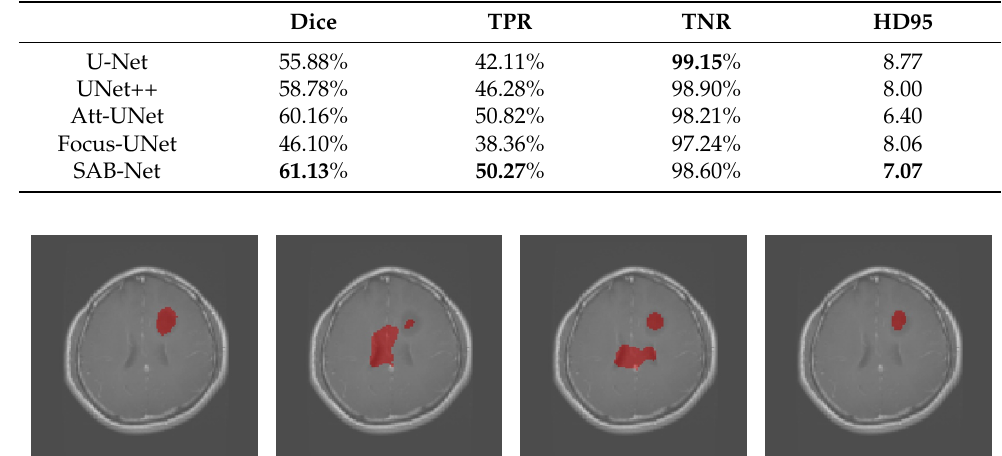
Figure 2. Qualitative results obtained for the brain MRI images. From left to right: ground truth, U-Net, Att-UNet, and SAB-Net.